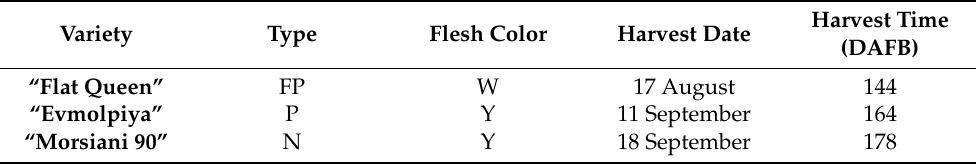
Table 7. Fruit type, flesh color, harvest date, and harvest time in days after full bloom (DAFB) of